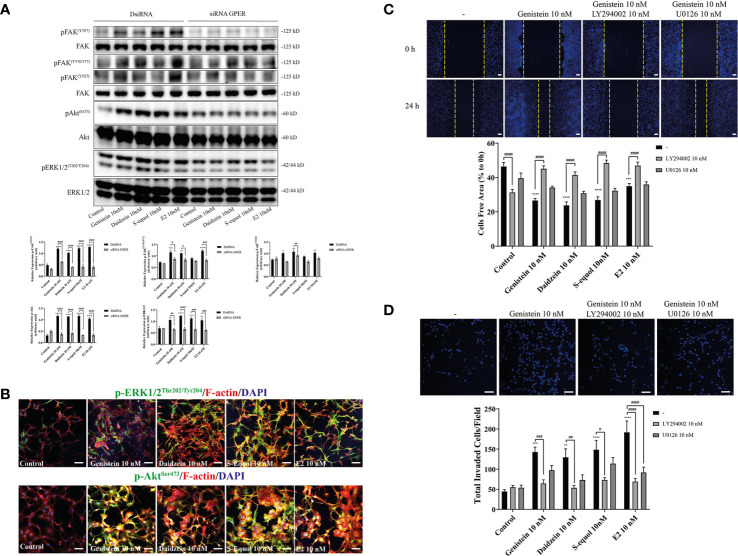
Effects of isoflavones on activation of the PI3K/FAK/Akt axis. (A) Western blot analysis of p-FAK, FAK, pERK1/2, ERK1/2, pAkt, and Akt levels after 30 min exposure of isoflavones or E2 in the astrocytes that have been transfected with DsiRNA or short interfering RNA (siRNA) G-protein-coupled estrogen receptor (GPER). Representative blots are shown in the upper panel, whereas quantitative analysis results are shown in the lower panel. (B) Representative photomicrographs showing immunocytochemistry results for pERK1/2 and pAkt, with F-actin and DAPI staining to examine the effects of isoflavones or E2 in C6 cells. C6 clonal cells were exposed to isoflavones for 30 min after serum starvation for 6 h. (C) Upper panel: Representative photomicrographs showing the effect of LY294002, a PI3K inhibitor, and/or U0126, an ERK1/2 inhibitor, on genistein-accelerated C6 cell migration measured using wound healing assay. Lower panel: Quantitative analysis of the effect of LY294002 or U0126 on isoflavones-accelerated C6 cell migration. (D) Upper panel: Representative photomicrographs showing the effect of LY294002, a PI3K inhibitor, and/or U0126, an ERK1/2 inhibitor, on genistein-accelerated C6 cell migration measured using cell invasion assay. Lower panel: Quantitative analysis of the effect of LY294002 or U0126 on isoflavones-accelerated C6 cell invasion. Bars represent 50 μm. Data are expressed as mean ± SEM and are representative of at least three independent experiments. ****p < 0.0001, ***p < 0.001, **p < 0.01, *p < 0.05, indicates statistical significance measured using Bonferroni’s test compared with control (-). ####
p < 0.0001, ###
p < 0.001, ##
p < 0.01, #
p < 0.05, indicates statistical significance measured using Bonferroni’s.